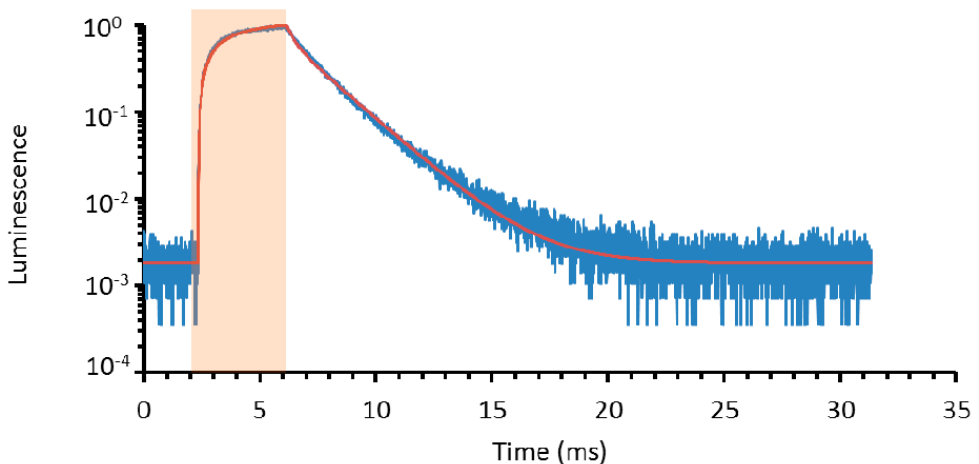
Figure 5. Time-resolved rise and decay curves of the Tb-centered UC emission intensity at 550 nm (in blue) upon time-gated excitation at 974 nm (8.1 kW cm − 2 , orange square) for a 9.5 × 10 − 5 M solution of YbL in D 2 O containing a 1.4 equivalent of TbCl 3 · 6H 2 O. The red line corresponds to the fit of the data (see text).